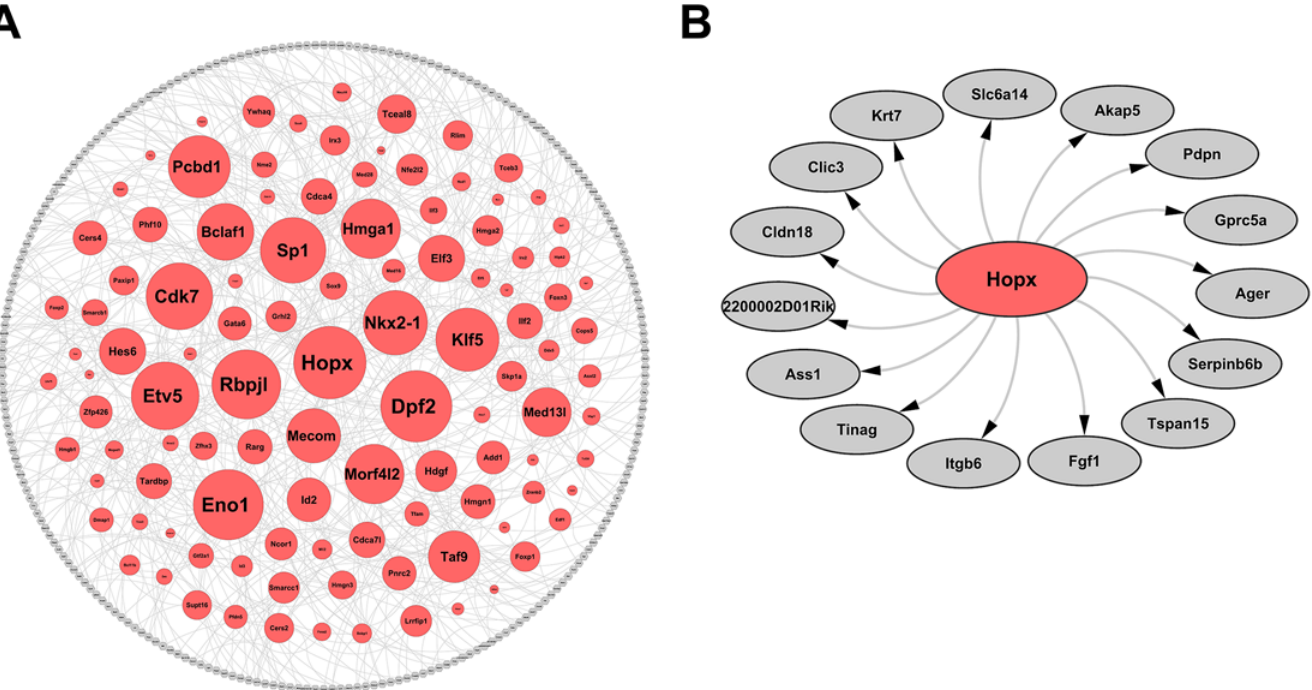
Fig 6. Mouse Lung Epithelial Specific Transcriptional Regulatory Network. (A) Rank importance of transcription factors (TFs) in the main connected component of epithelial specific transcriptional regulatory network (TRN). The sizes of the TF nodes are proportional to their average-ranked node importance. The main connected component of epithelial TRN is comprised of 348 nodes and 432 edges. The nodes in red are the TFs and the nodes in grey are differentially expressed genes (p-value < 0.01) in epithelial cells and are not TFs. The edges were established using the first-order conditional dependence approach described in the Methods section with a cutoff at 0.05. (B) The Hopx local network (the first hop is shown). Hopx was the top ranked TF identified by driving force analysis ( Table 1 ).